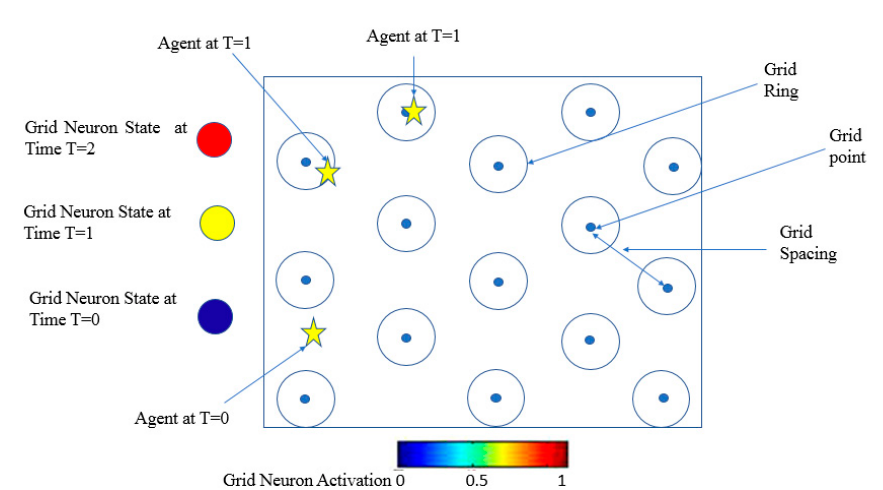
Figure 1. Grid neuron activation.